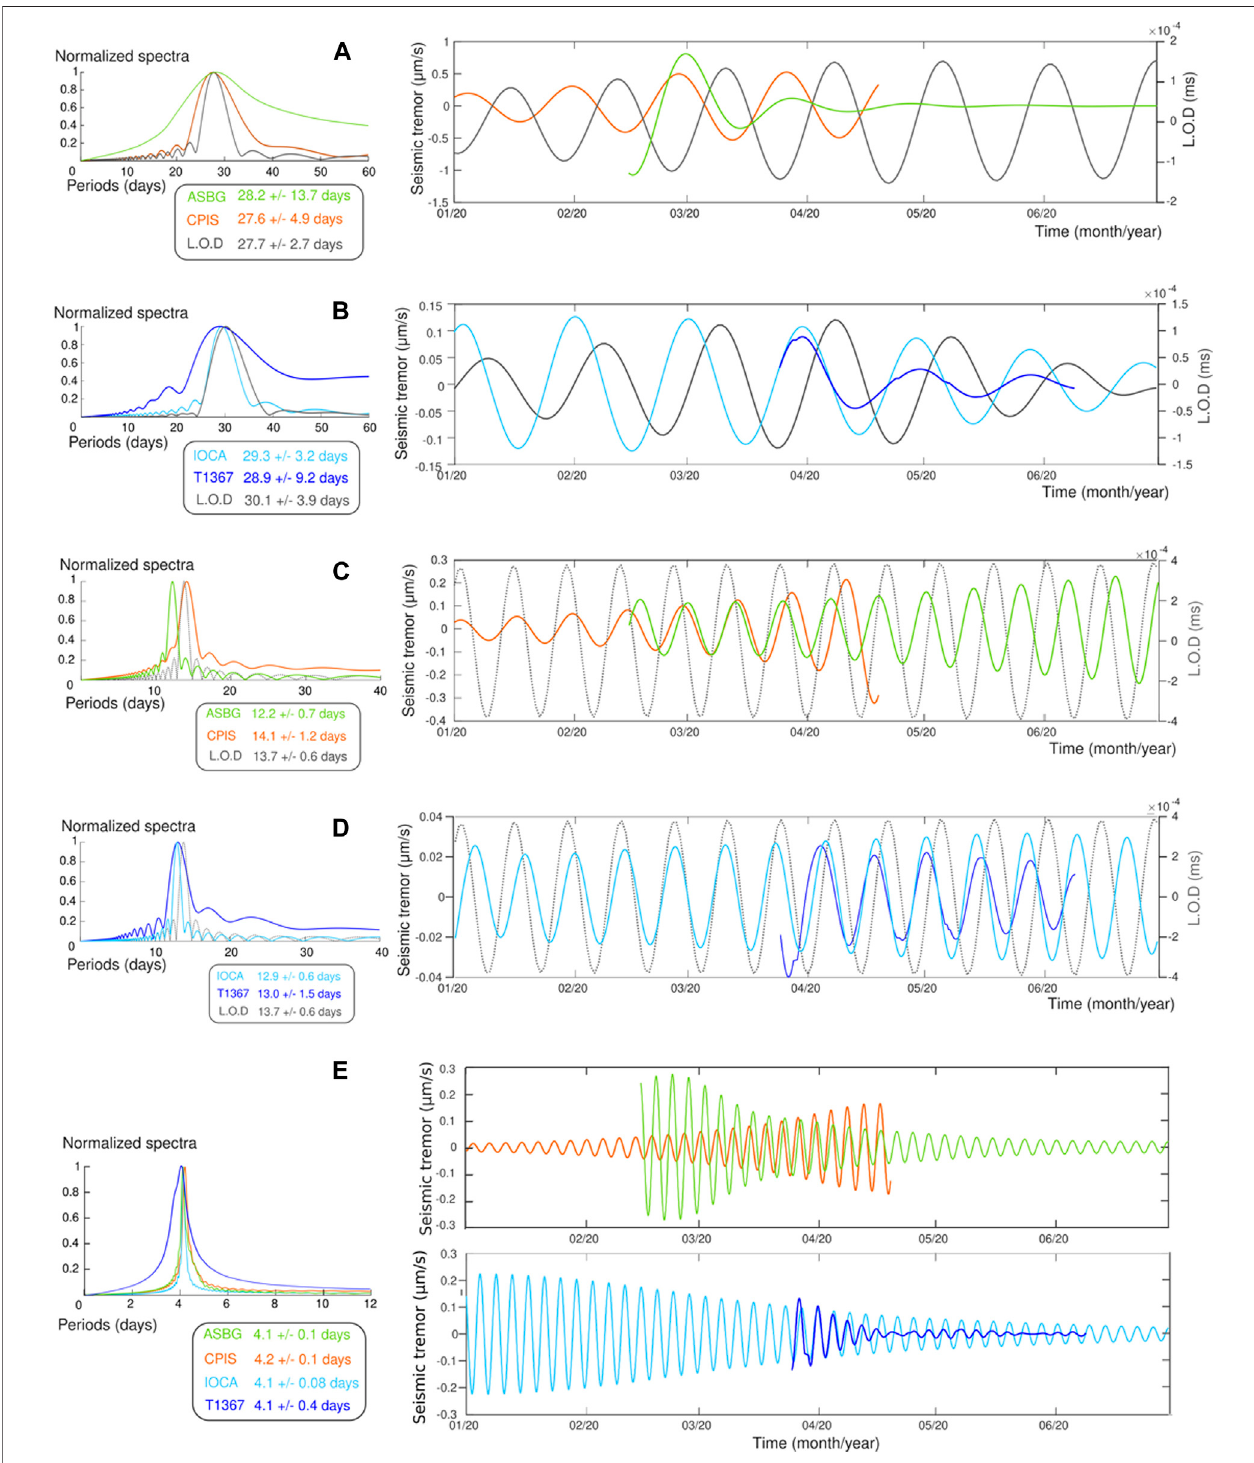
FIGURE 3 | Tidal components extracted in the seismic tremor and l.o.d. time-series for (A – B) ∼ 27 – 31 (Mm/MSm) and (C – D) ∼ 13 days (Mf/MSf). Panel (E) representsthe ∼ 4-dayperiod extracted inallfourseismictremor time-serieswhichlikelycorrespondstotheharmonicoflonger-period tides.Thenormalized spectraare shown on the left side and the corresponding waveforms on the right.